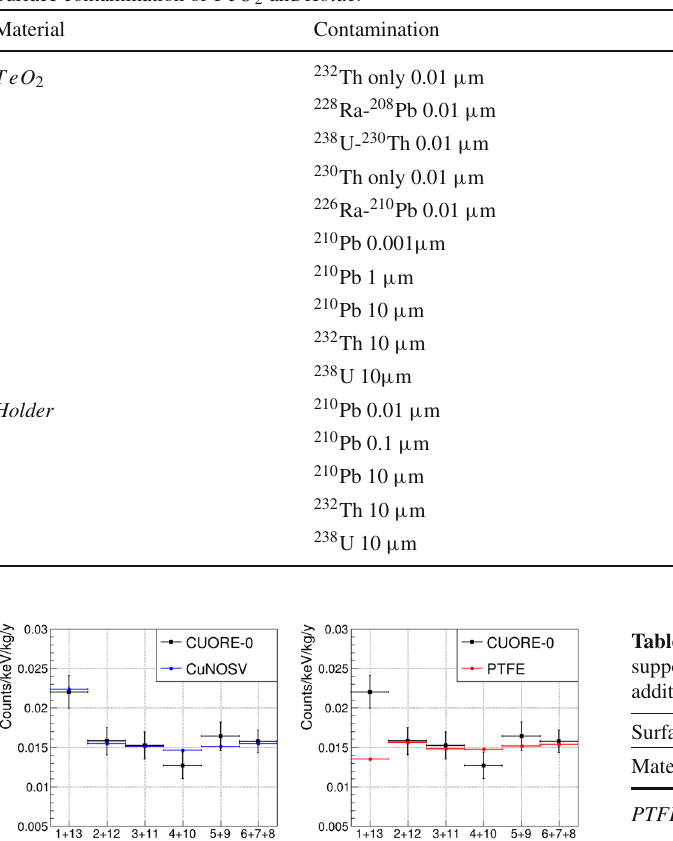
Table 6 90% C.L. upper limits and values for surface contamination of the TeO 2 crystals and the Holder based on the background model of CUORE-0 [42]. Contaminants are identified as follows: when the progenitor is indicated all the chain is assumed in secular equilibrium,